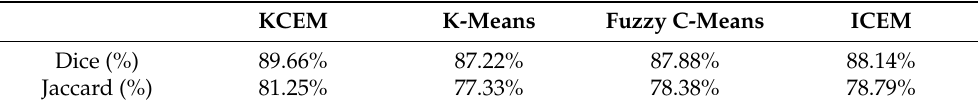
Table 5. Mass tumor: Dice similarity coefficient and Jaccard similarity coefficient of each